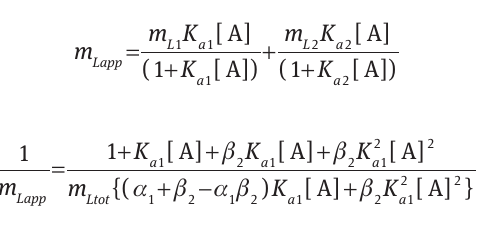
Table 1 Association equilibrium constants ( K l-tryptophan with normal HSA and various samples of in vitro